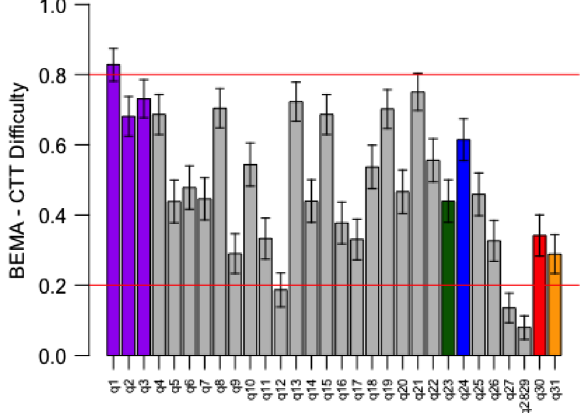
FIG. 2. The error bars are (cid:2) 2 standard deviations from 10 000 randomly sampled classes of 250 students from the full sample for the BEMA. The horizontal red lines indicate an ideal range of difficulties for well-functioning questions. The colored bars are the 7 identical items between the BEMA and